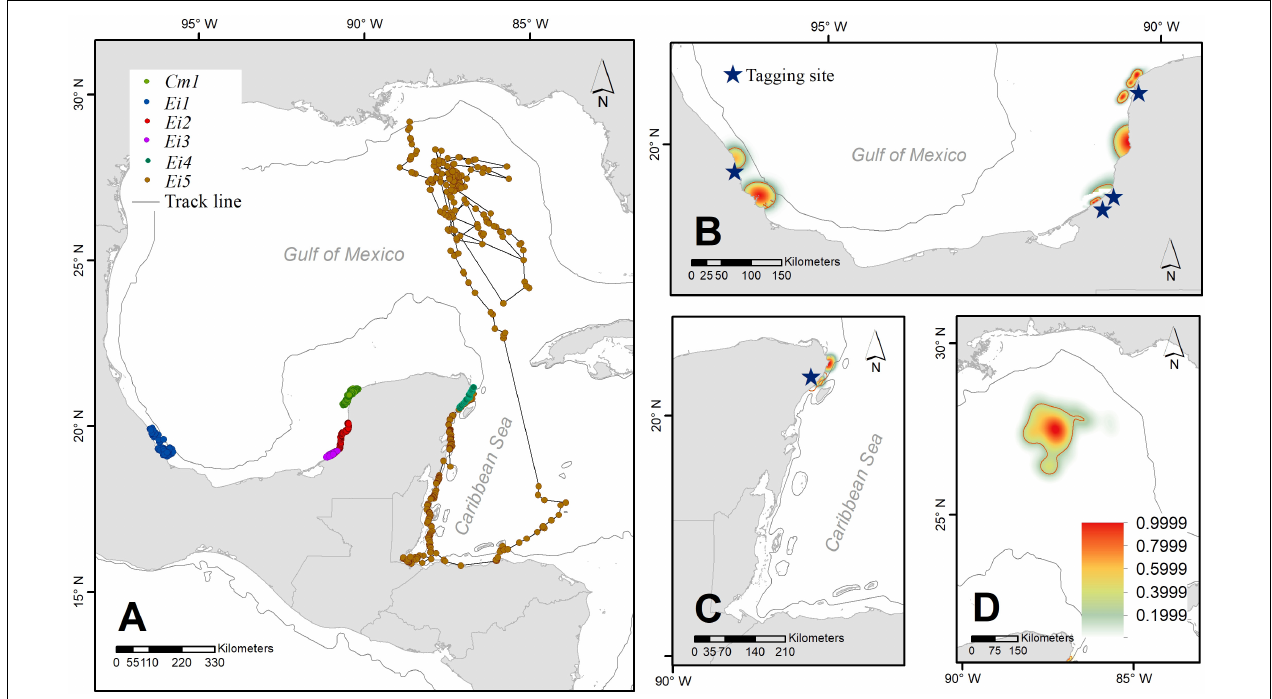
FIGURE 1 | Pathways of six satellite-tracked male sea turtles (five hawksbills and one green) after stranding, subsequent rehabilitation, and release from capture locations on shore (blue stars) (A) . Their home ranges (75%, red polygons) are presented together with space use distribution kernels for all individuals ( Ei 1, Ei 2, Ei 3, and Cm 1) (B) , Ei 4 and Ei 5 (C) , and the open ocean home range Ei 5 (D) .